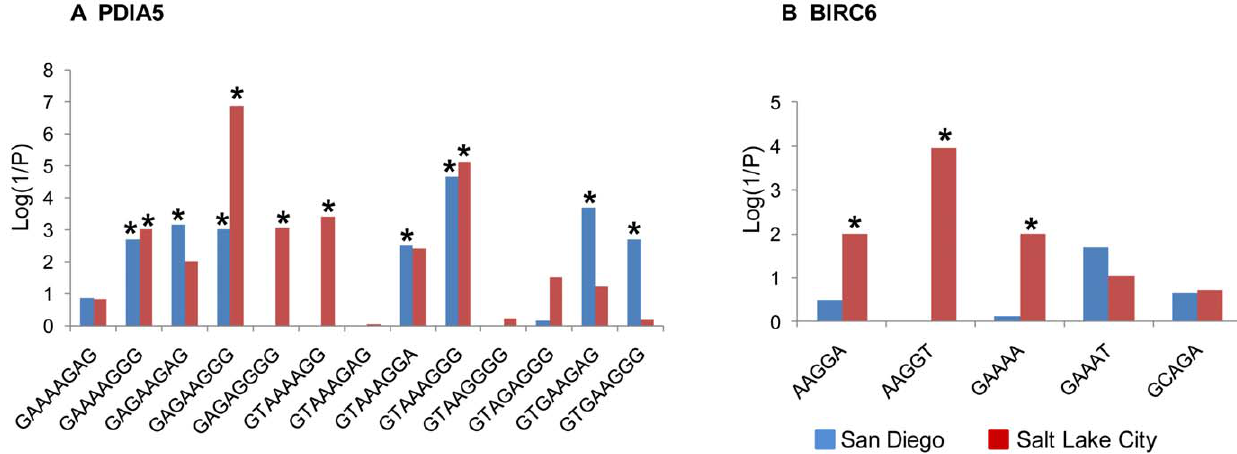
Figure 2. Association of PDIA5 (A) and BIRC6 (B) haplotypes with POAG. The graphs show the Fisher’s P-values (Log(1/P); y-axis) with the haplotypes (x-axis) from 2 populations (San Diego (blue) and Salt Lake City (red). The PDIA5 haplotypes are composed of the following rsSNPs: rs11720822, rs2241962, rs2667465, rs3792361, rs3792390, rs4677994, rs702029, rs836833. The BIRC6 haplotypes are composed of the following rsSNPs: rs12612824, rs17820747, rs2069213, rs2254106, and rs2754511. Haplotypes with frequencies , 0.03 were excluded from the analysis. Haplotypes significantly associated with POAG are indicated with an asterisk (Bonferroni adjusted P , 0.004 for PDIA5; Bonferroni adjusted P , 0.01 for BIRC6).